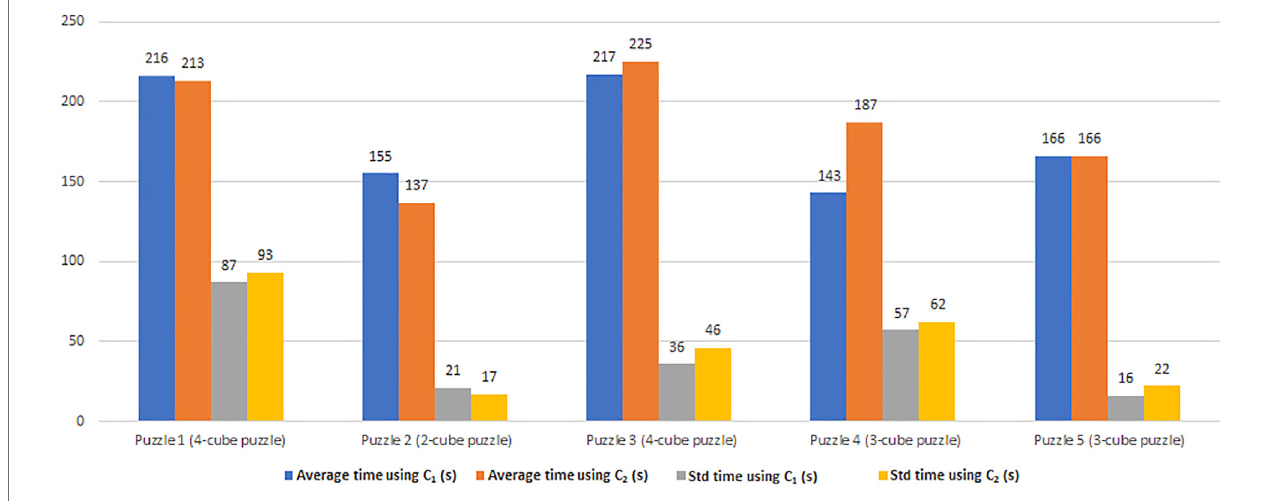
FIGURE 5 | The average time and the standard deviation in seconds of the time taken to do the task with the state-of-the-art utility function ( C 1 ) and the utility function used to optimize the time ( C 2 ), which is our